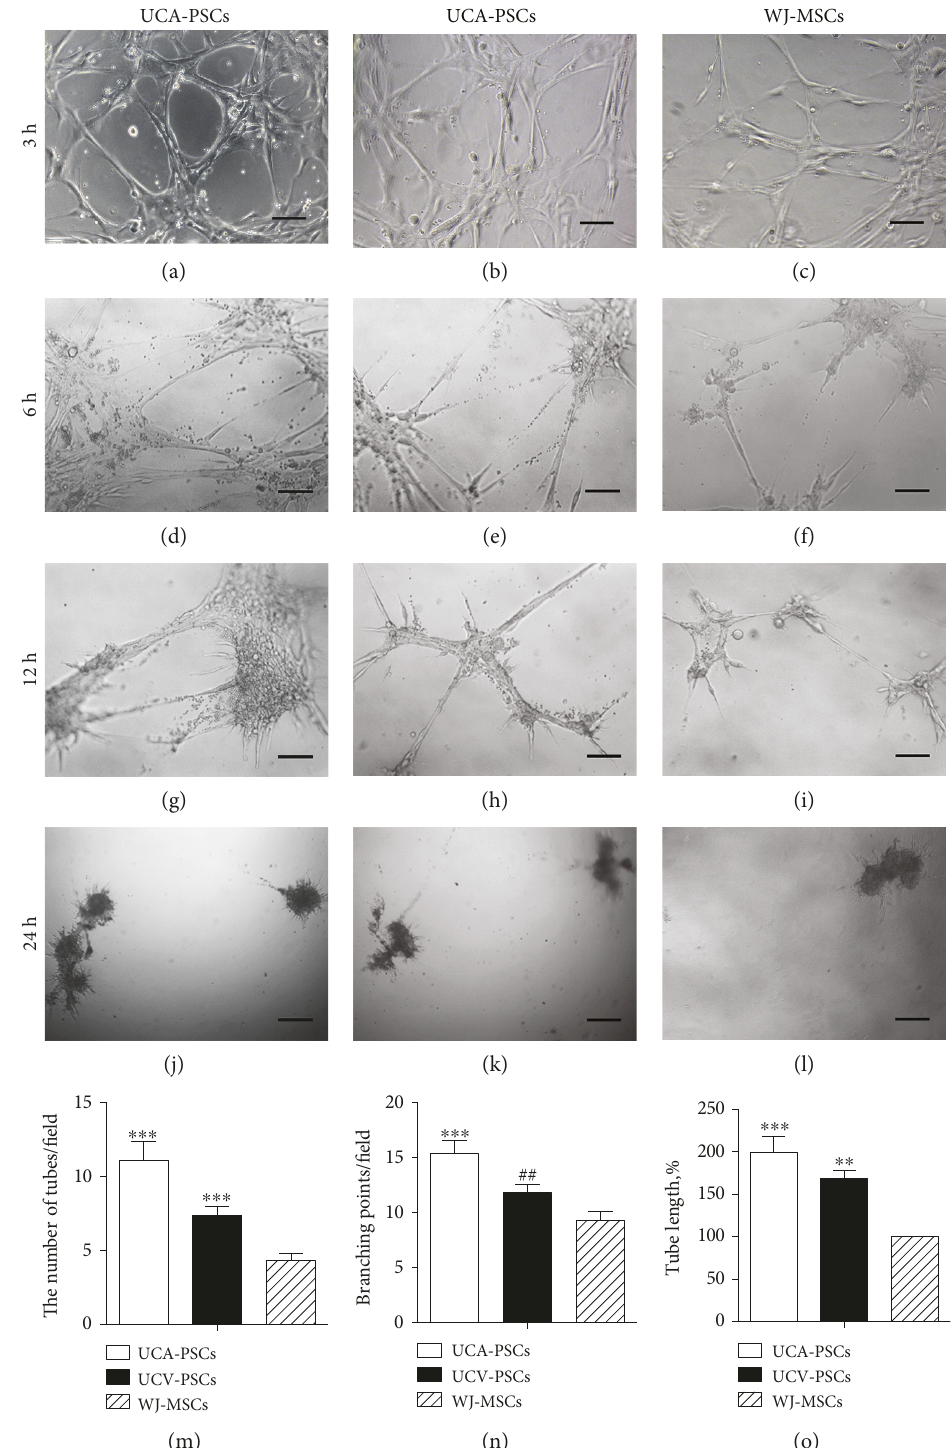
Figure 5: In vitro Matrigel tube formation assay. Umbilical cord artery perivascular stem cells (UCA-PSCs), umbilical cord vein perivascular stem cells (UCV-PSCs), and Wharton ’ s jelly mesenchymal stem cells (WJ-MSCs). Cells (1 × 10 4 /well) were treated with a low concentration of glucose and plated on Matrigel in 96-well tissue culture plates. Tube formation was microscopically compared after 3h (a – c), 6h (d – f), 12h (g – i), and 24h (j – l). Bar: 60 μ m. The number of tubes (m) and branching point per fi eld (n) and the total length of tubes per fi eld (o) were quanti fi ed 3 h after treatment by counting 3 – 5 random fi elds/well under the microscope (magni fi cation: 100x). UCA-PSCs and UCV-PSCs, especially UCA-PSCs, displayed greater tube formation ability than WJ-MSCs. n = 5 . ∗∗∗ P < 0 001 , versus WJ-MSCs. ∗∗ P < 0 01 , UCV-PSCs versus WJ-MSCs. ## P < 0 01 , UCV-PSCs versus